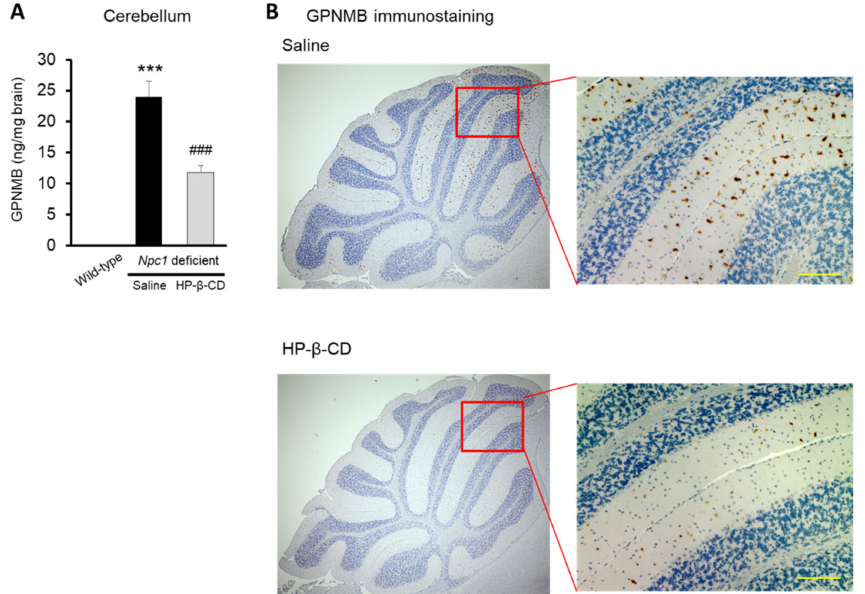
Figure 3. Intracerebroventricular treatment with 2-hydroxypropyl- β -cyclodextrin (HP- β -CD) attenuated the abnormal increase of glycoprotein nonmetastatic melanoma protein B (GPNMB) expression in Npc1 − / − mice. Assays of GPNMB levels in brain using ELISA ( A ) and immunohistochemical staining of GPNMB ( B ) were performed. Scale bar: 100 µ m. Data are presented as the mean ± S.E. ( n = 4–7). *** p < 0.01 compared with the wild-type group. ### p < 0.001 compared with the saline